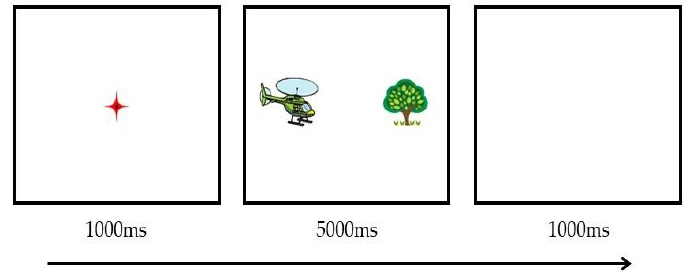
Figure 1. A schematic example of a trial sequence in Experiment 1. The airplane on the left is an example of a CI-related item, and the tree on the right is a non-CI item.